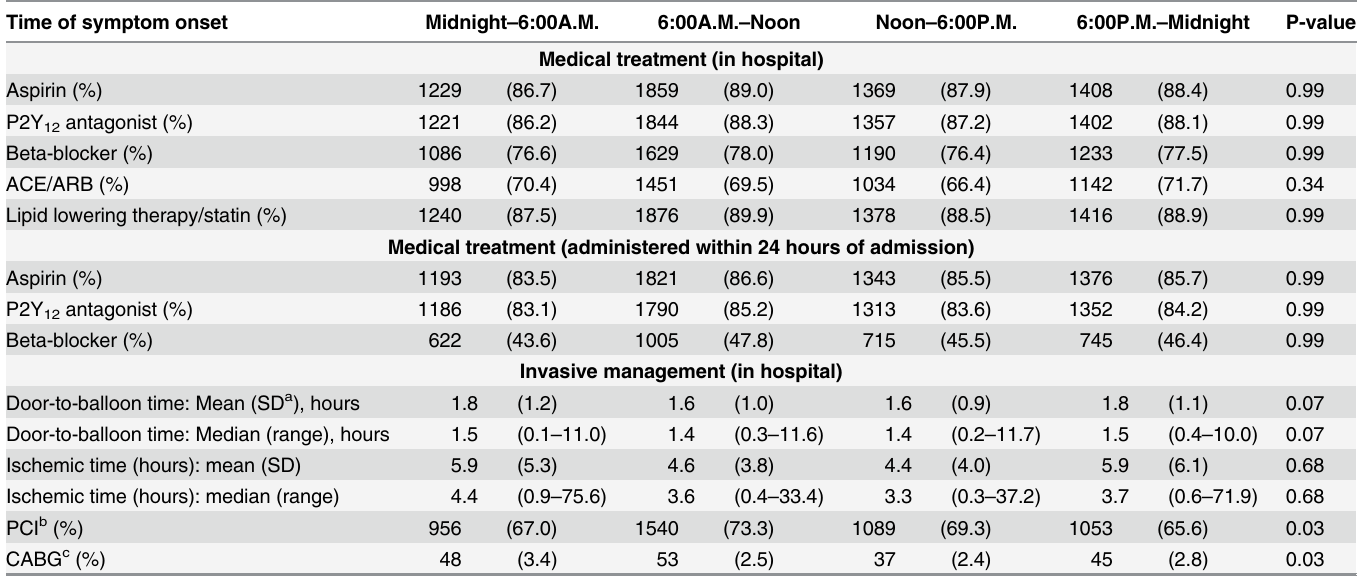
Table 2. Treatment differences among different time